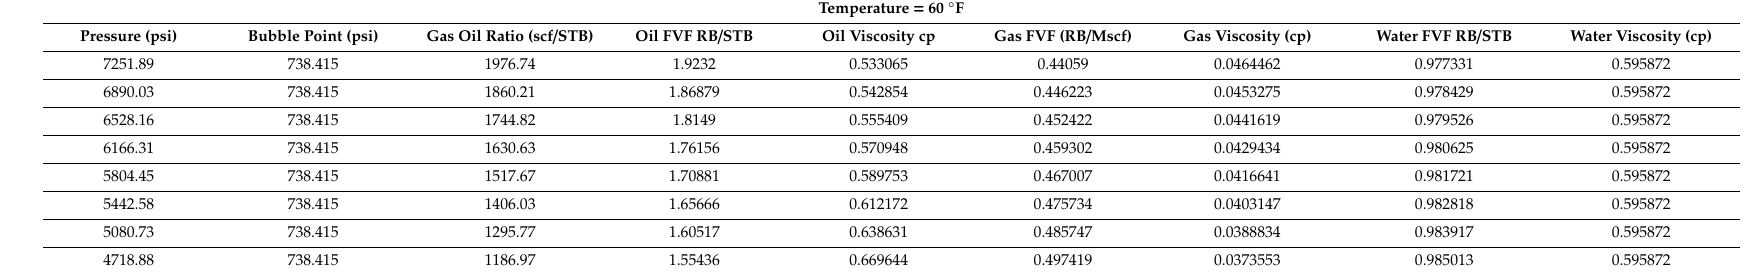
Table A5. PVT properties at 60 ◦